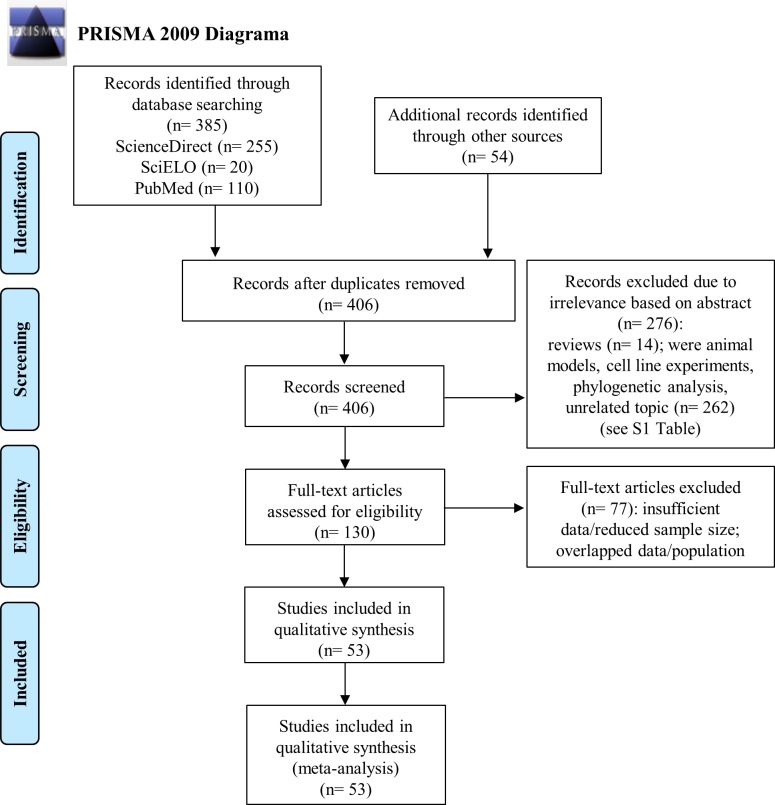
PRISMA 2009 flow diagram of observational studies included in the meta-analysis.